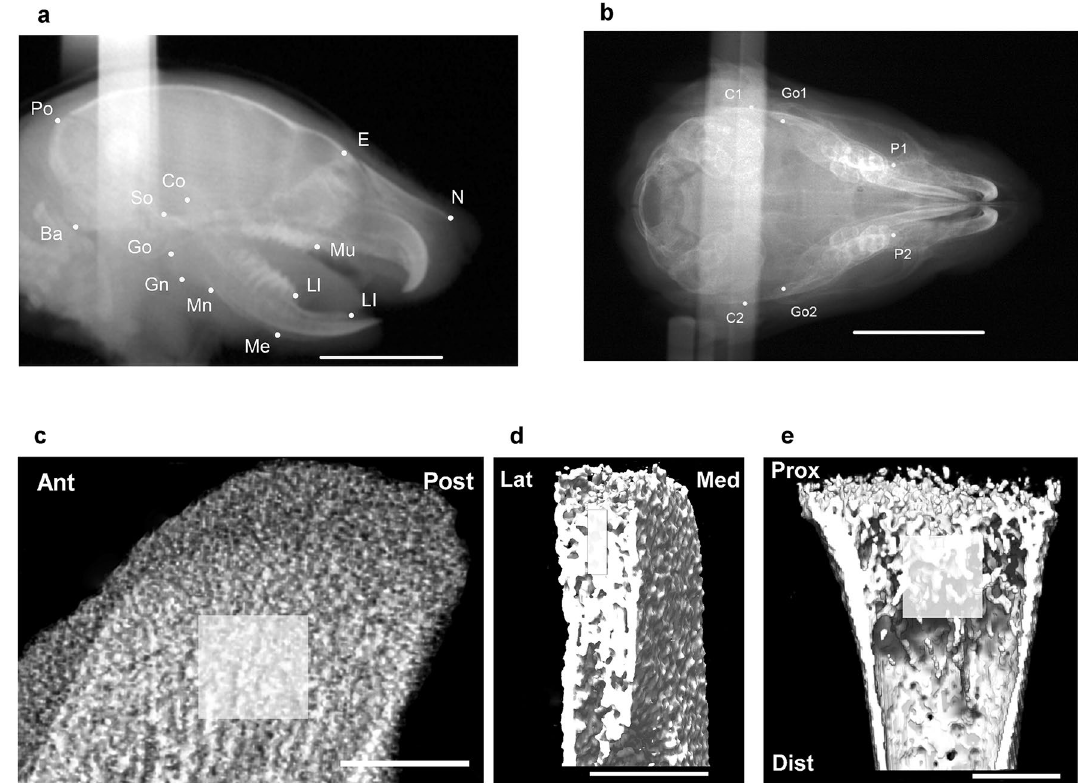
Figure 1. Cephalometric and μCT analysis landmarks. ( a ) Lateral cephalometric and ( b ) dorsoventral cephalometric view in a 2-week-old rat. Region of interest (ROI) in μCT images, including sagittal ( c ) and coronal ( d ) views of mandibular condyle and coronal ( e ) view of proximal tibial epiphysis. Boxes in ( c – e ) indicate the ROI. Scale bar = 10 mm ( a , b ) and 50 μm ( c – e ). Ant anterior, Dist distal, Lat lateral, Med medial, Post posterior, Prox